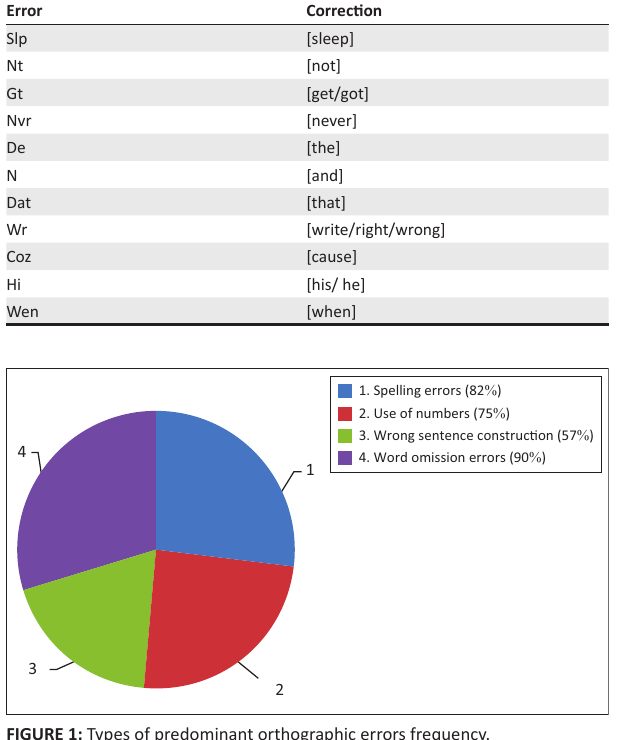
TABLE 4: WhatsApp words used by the learners in their written